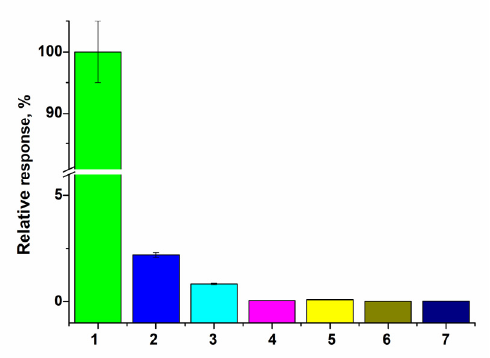
Figure A3. The selectivity test for the CuCe/GE: comparison of current responses on the added analytes up to 2 mM concentration: H 2 O 2 (1), L-Arg (2), glucose (3), methylamine (4), methanol (5), ethanol (6), and catechol (7). Conditions: working potential − 50 mV vs. Ag/AgCl (reference electrode), 50 mM acetate buffer, pH 4.5 at 23 °C.